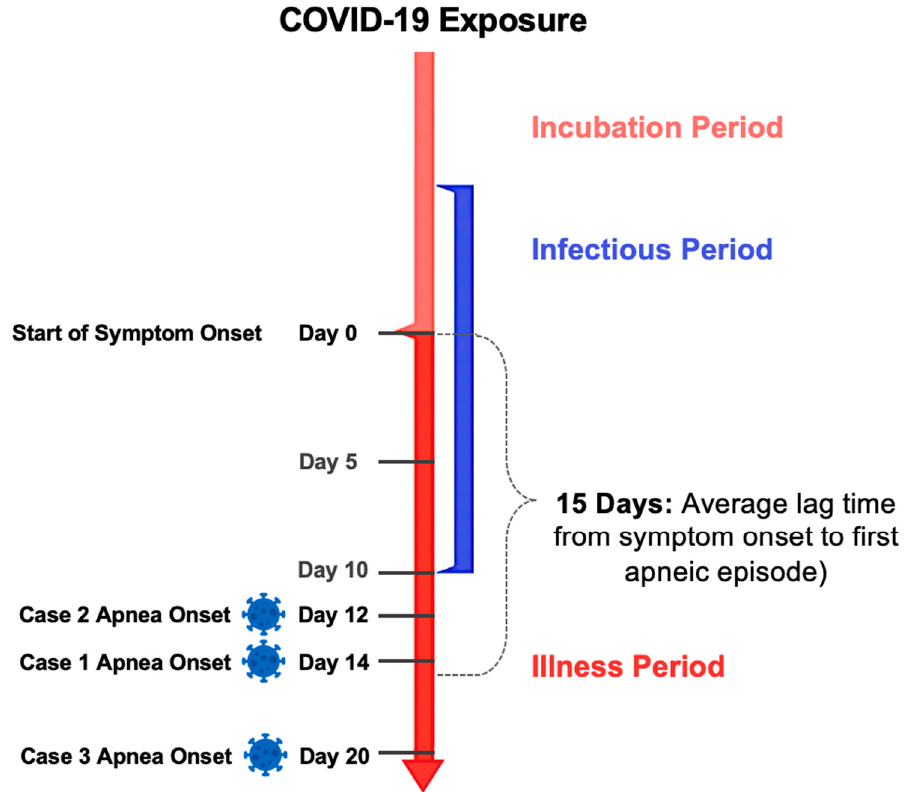
Figure 1. Timeline of events after COVID-19 exposure. Onset of symptoms marked as day 0. Length of infectious period for the average COVID-19 patient is 10 days after onset of symptoms, as per current CDC guidelines. Time from onset of symptoms to first apneic episode was 14 days, 12 days, and 20 days for case 1, case 2, and case 3, respectively.